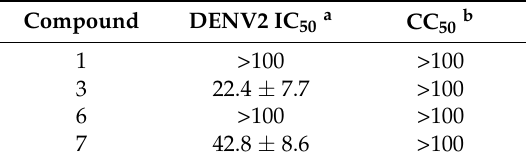
Table 2. DENV2 activity ( µ M) and cytotoxicity data ( µ M) of the test